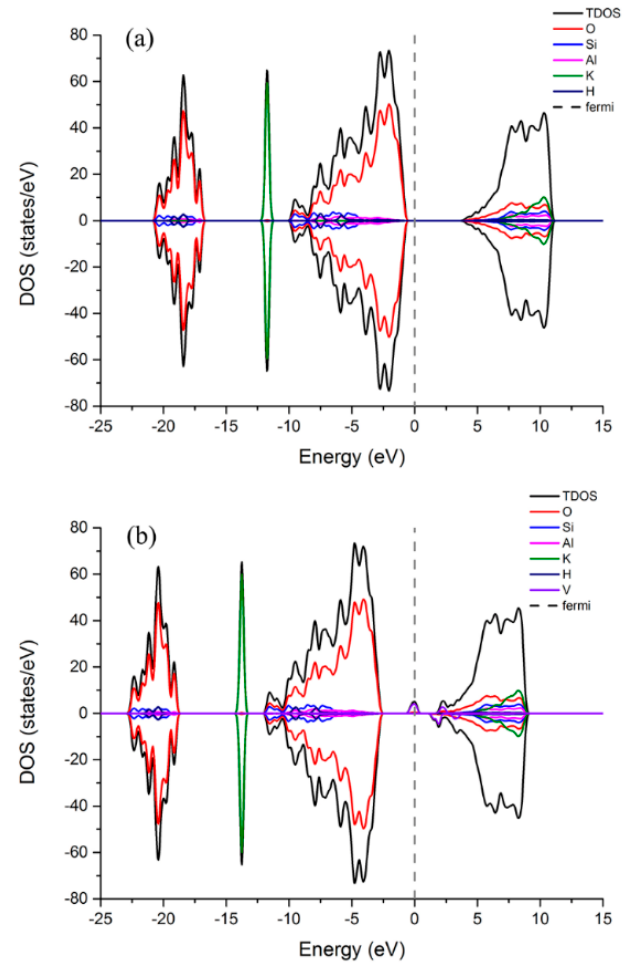
Figure 7. The density of states (DOS) curves of ( a ) muscovite and ( b ) muscovite doped with V.